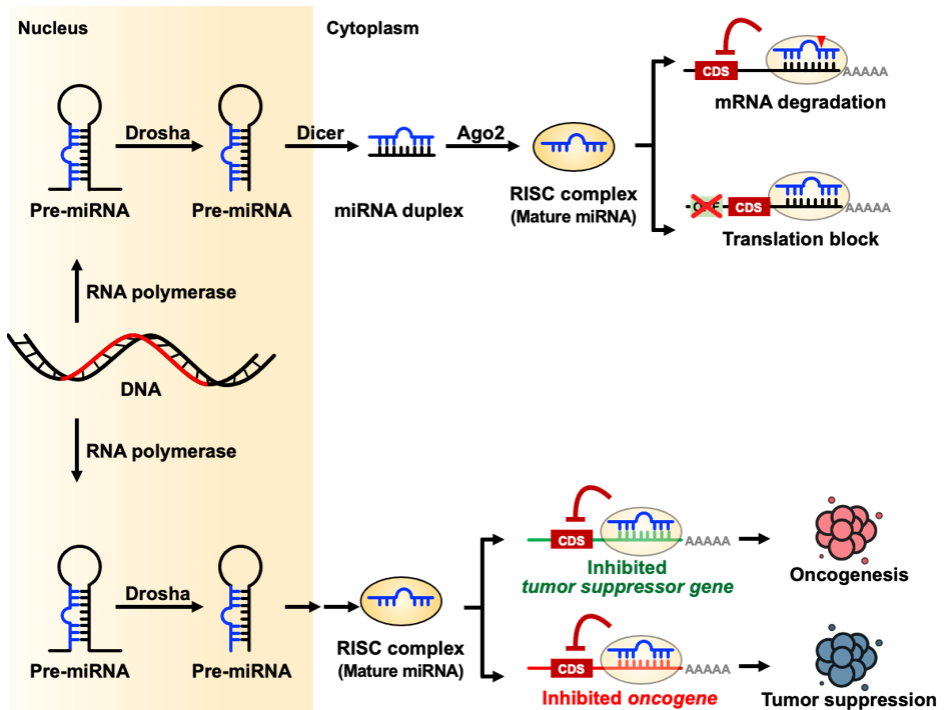
Figure 1. microRNA biogenesis and their biological functions.